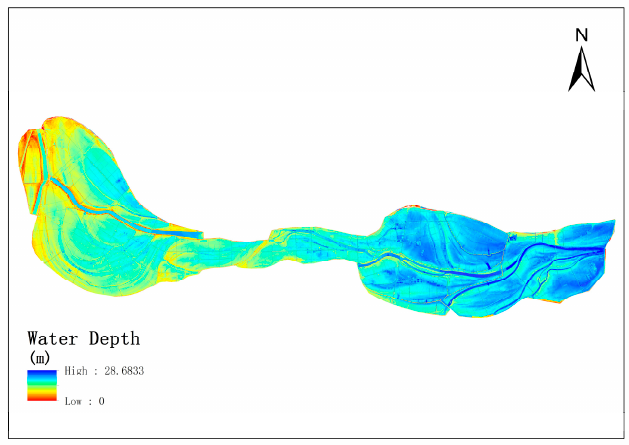
Figure 6. Calculated flood depth.